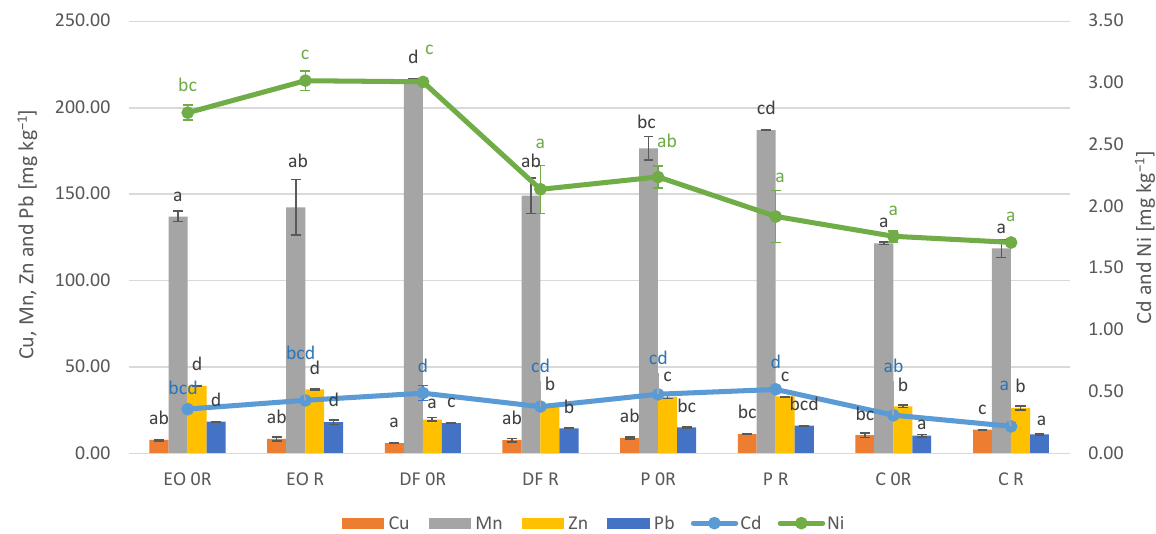
Figure 3. The effect of PDSs and bioremediation on the content of heavy metals in the experimental soils (acid-extracted elements). The means ( ± SE) for individual elements that are marked with the same letters did not differ significantly according to Tukey’s test at p < 0.05. The symbols are the same as those in Table 3.